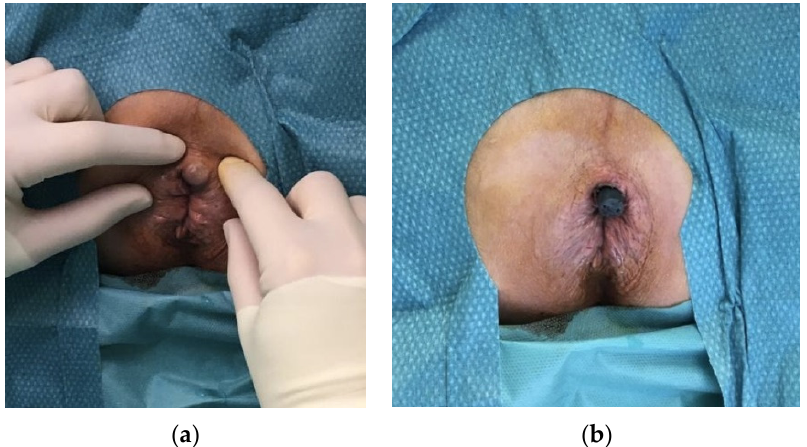
Figure 1. ( a ) Migration of a prosthesis towards the perineal skin. ( b ) Perineal skin already cut, with the prosthesis visible.